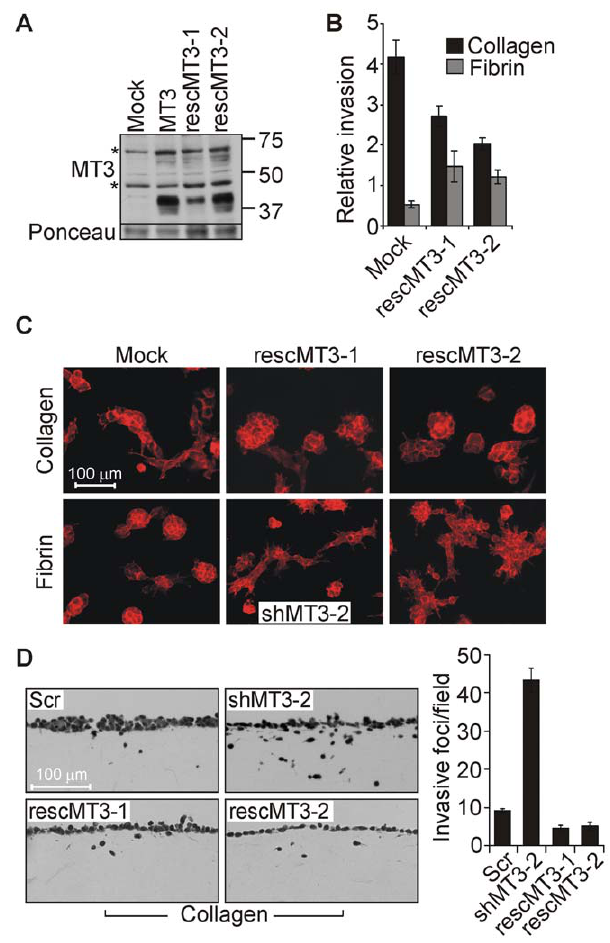
Figure 7. Transient MT3-MMP expression in the MT3-MMP knockdown cells rescues nodular-type growth in collagen in conjunction with increased fibrin invasion. (A) MT3-MMP was detected by immunoblotting in COS-1 cells transiently expressing mock vector (Mock), MT3-MMP (MT3), or rescue constructs rescMT3-1 and rescMT3-2. Ponceau staining served as a loading control. Asterix marks non-specific bands. (B) WM852 cells stably expressing MT3-MMP targeting shRNA (shMT3-2) transfected to express MT3-MMP rescue vectors (rescMT3-1 and rescMT3-2) or mock vector were embedded in 3D collagen type I and fibrin gels. Chart shows relative percentage of invasive colonies formed after 5 d, n=3. (C) Fluorescent micrographs show representative colonies stained for F-actin (red) to visualize the cells. (D) WM852 cell pools after lentiviral expression of scrambled shRNA (Scr) and shMT3-2 as well as knockdown cells transfected with MT3-MMP rescue vectors (rescMT3-1 and rescMT3-2) were allowed to invade into collagen type I gels for 7 d followed by imaging and quantification, n=3.